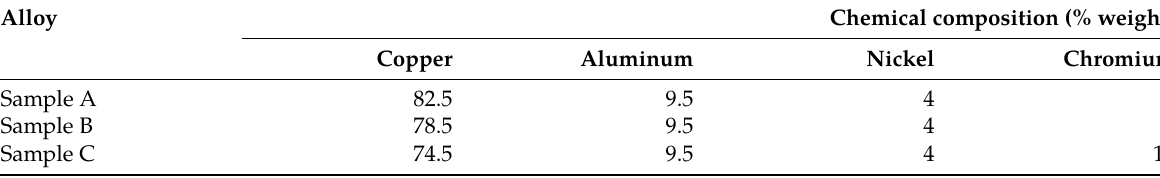
Table 1: Alloy sample composition.